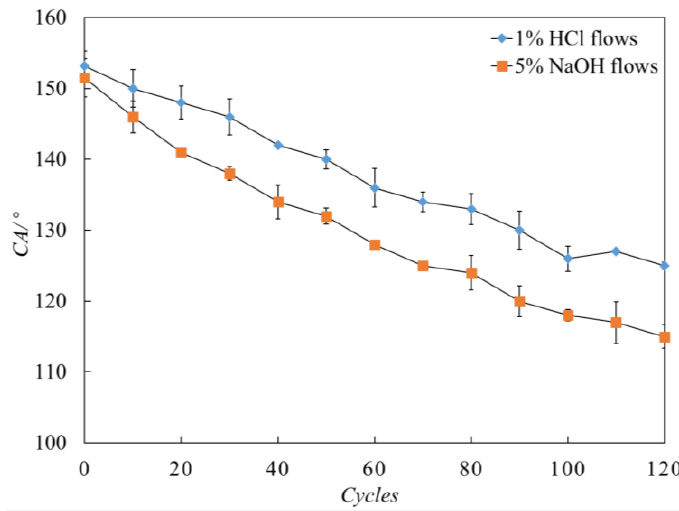
Figure 14. CA changes after 120 cycles.